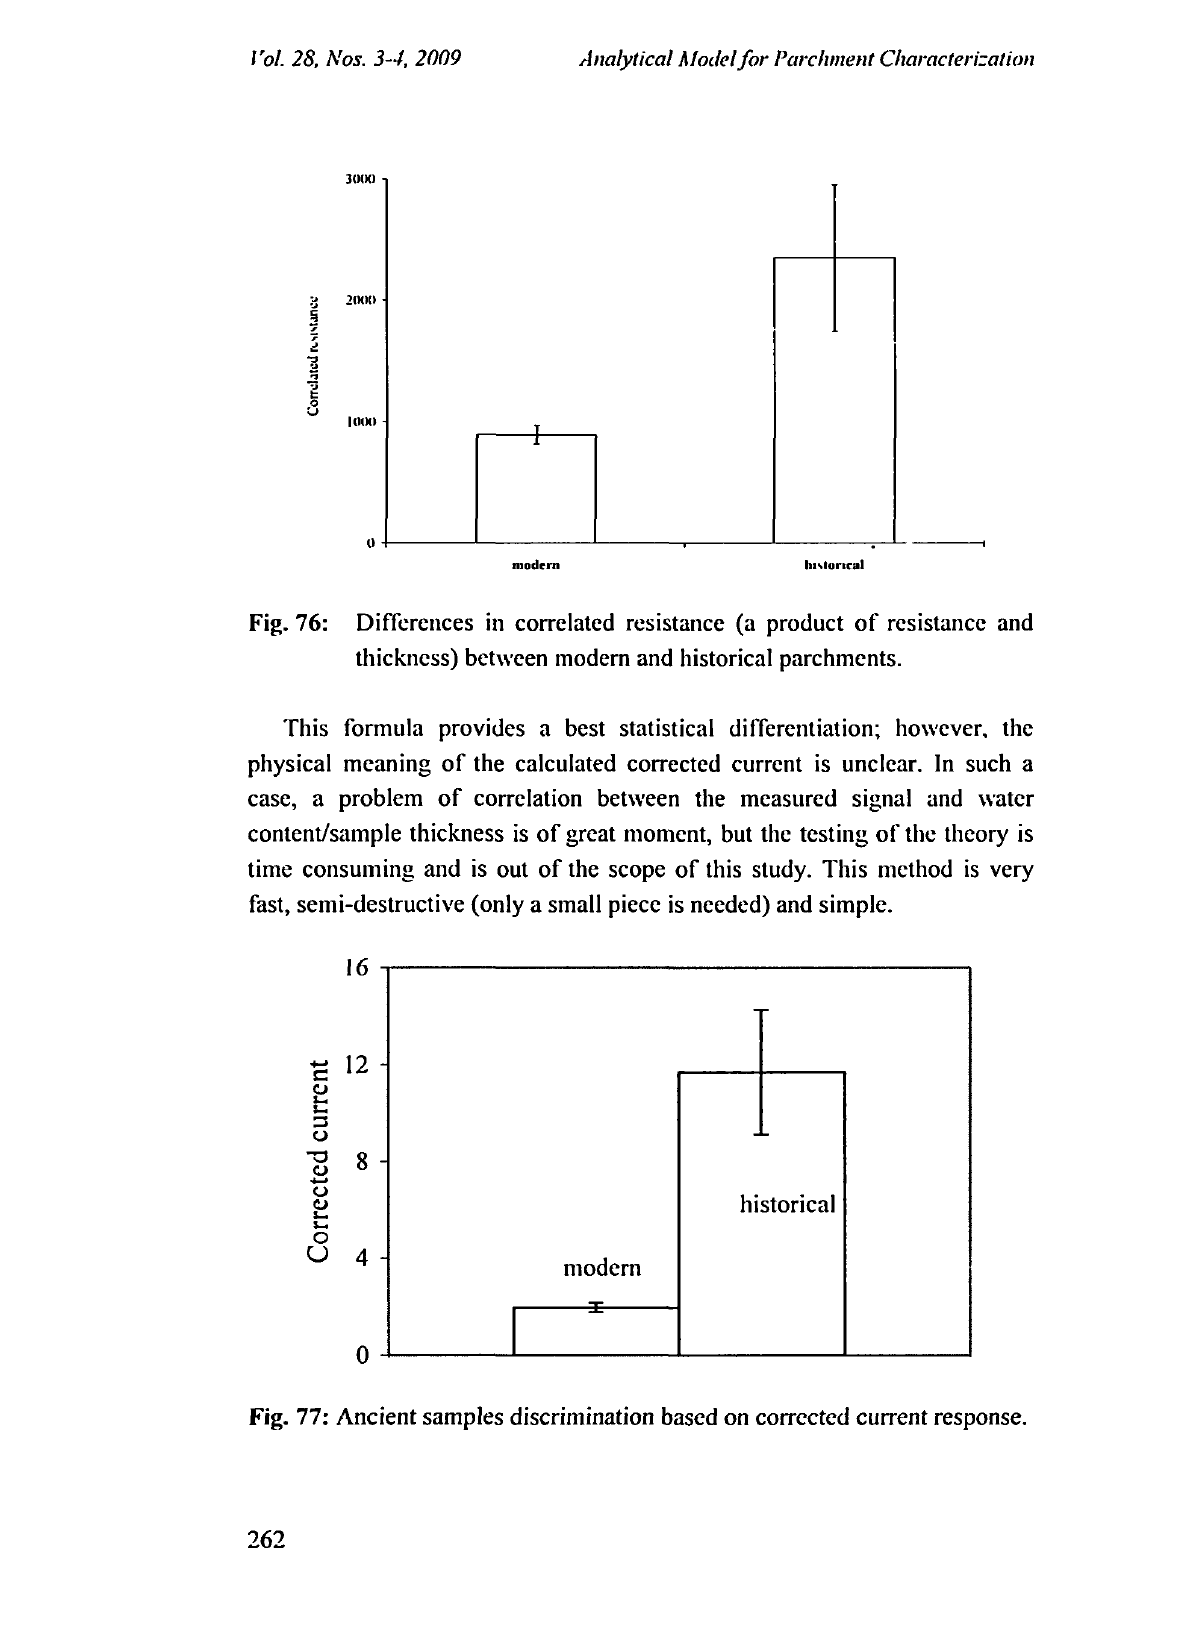
Fig. 76: Differences in correlated resistance (a product of resistance and thickness) between modern and historical parchments.